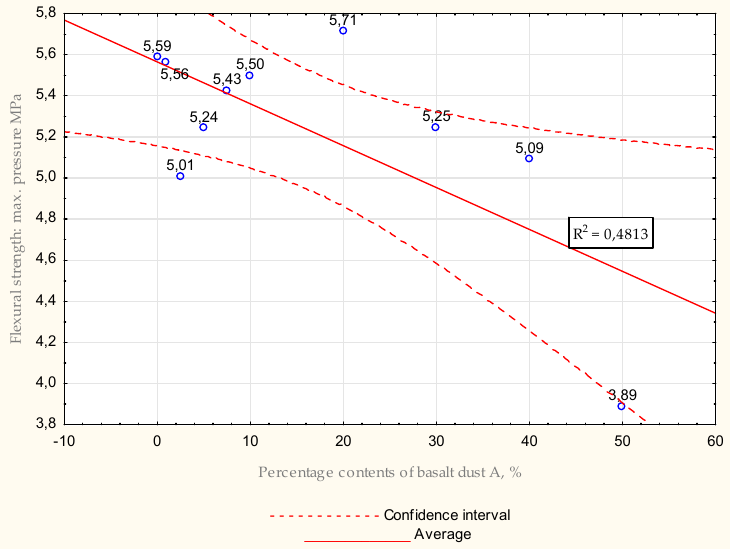
Figure 24. Average values obtained during flexural strength tests for water − mix ratio = 0.7, maximal pressure.